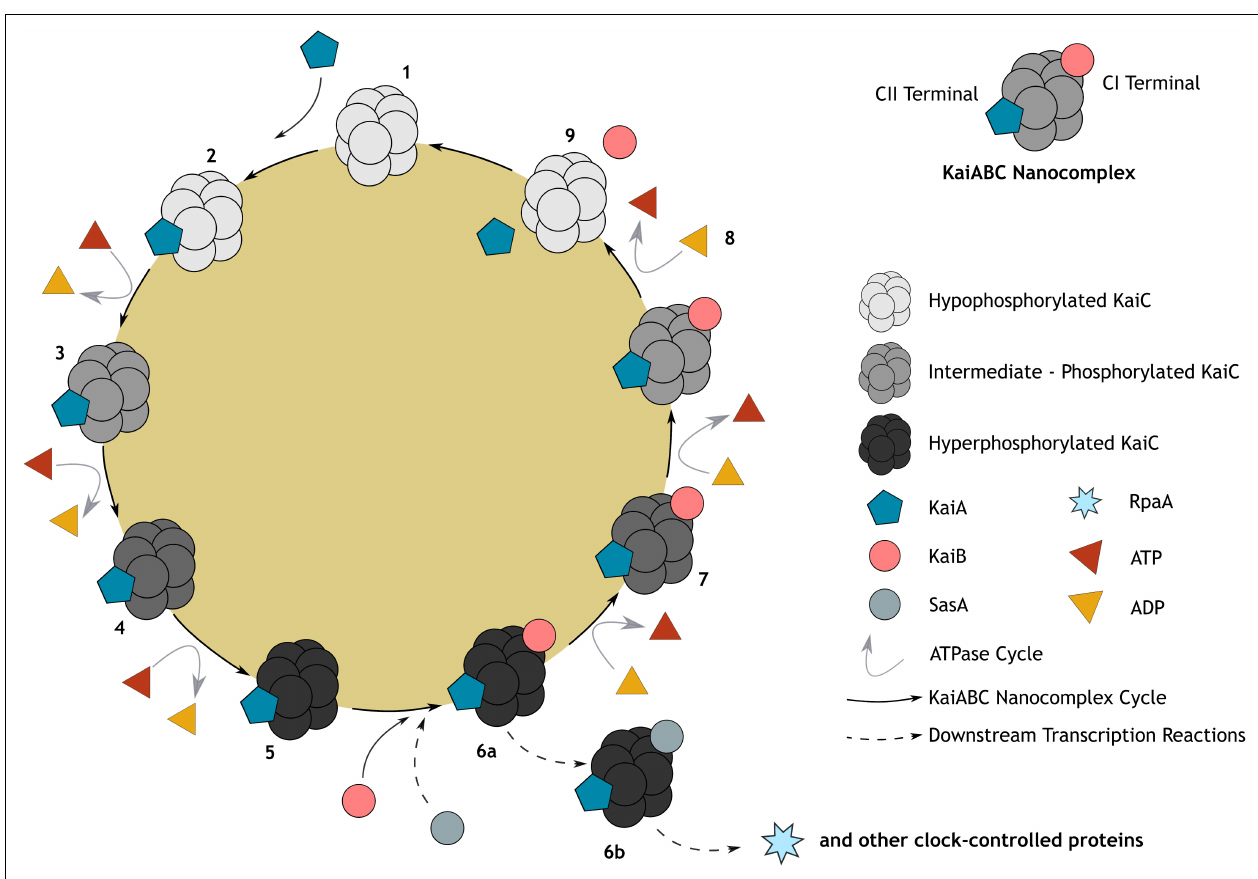
FIGURE 1 | Representation of the canonical cyanobacterial post-translational (KaiABC) circadian clock. Post-translational oscillation occurs through a cycle of association and disassociation from the KaiABC nanocomplex, embedded within a gene expression feedback loop (GEFL). KaiC, a double hexamer ( 1 ), serves as the central oscillator and is both an autokinase and autophosphatase, exhibiting ATPase activity (Cohen and Golden, 2015); whilst KaiA and KaiB rhythmically bind to KaiC either leading to its phosphorylation or de-phosphorylation, respectively. Briefly, unphosphorylated KaiC ( 1 ) is stimulated through its interaction with KaiA at the CII terminal, leading to KaiC phosphorylation in the CII domain ( 2–5 ). At the point at which KaiC reaches hyperphosphorylation ( 5 ) of two key residues (T432 followed by S431), KaiB will then bind to the CI terminal of KaiC stably ( 6a ). This sequesters KaiA activity and once again initiates KaiC dephosphorylation ( 6a–8 ; Kitayama et al., 2003; Chang et al., 2012). When KaiC is hypophosphorylated, KaiB and KaiA are released, launching a new cycle ( 9 ). Because of their similar structure, KaiB and SasA (Kai-C interacting histidine kinase) compete to bind with KaiC ( 6b ), regulating downstream transcriptional factors such as RpaA (transcriptional factor) and global gene expression of clock-controlled genes, including those that drive the essential oscillators, KaiABC (Takai et al., 2006; Taniguchi et al., 2010; Johnson et al., 2011). At the core of this cycle, activity of ATPase (predominantly at the CI domain of KaiC) sustains the robust temperature compensated rhythms through catalyzing a remarkably slow rate of ATP hydrolysis (15–16 ATP molecules hydrolyzed by one KaiC monomer per day). This is hypothesized to be the rate-limiting component of the cycle, mediating KaiABC activity such that they oscillate precisely to produce a period of ∼ 24 h (Terauchi et al., 2007; Abe et al.,